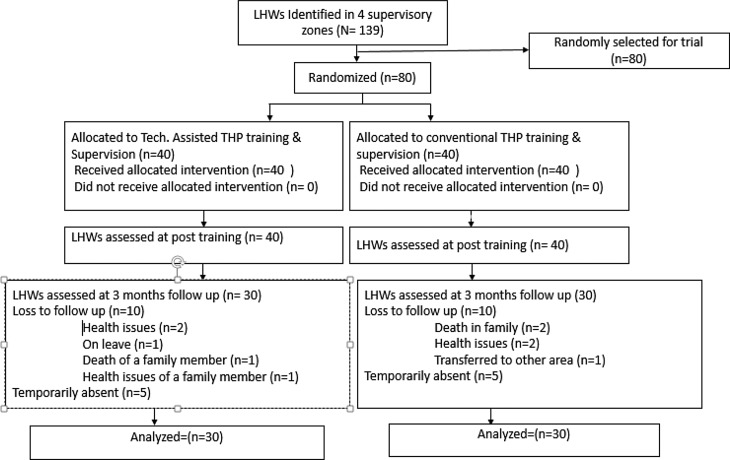
Participants' flow.